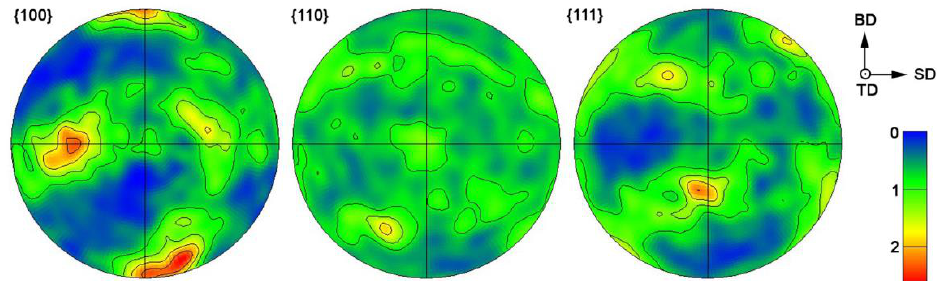
Figure 4. Pole figures constructed for fcc α -Al phase. The orientation of the specimen coordinate system and the relative intensity of the diffraction peaks are shown.